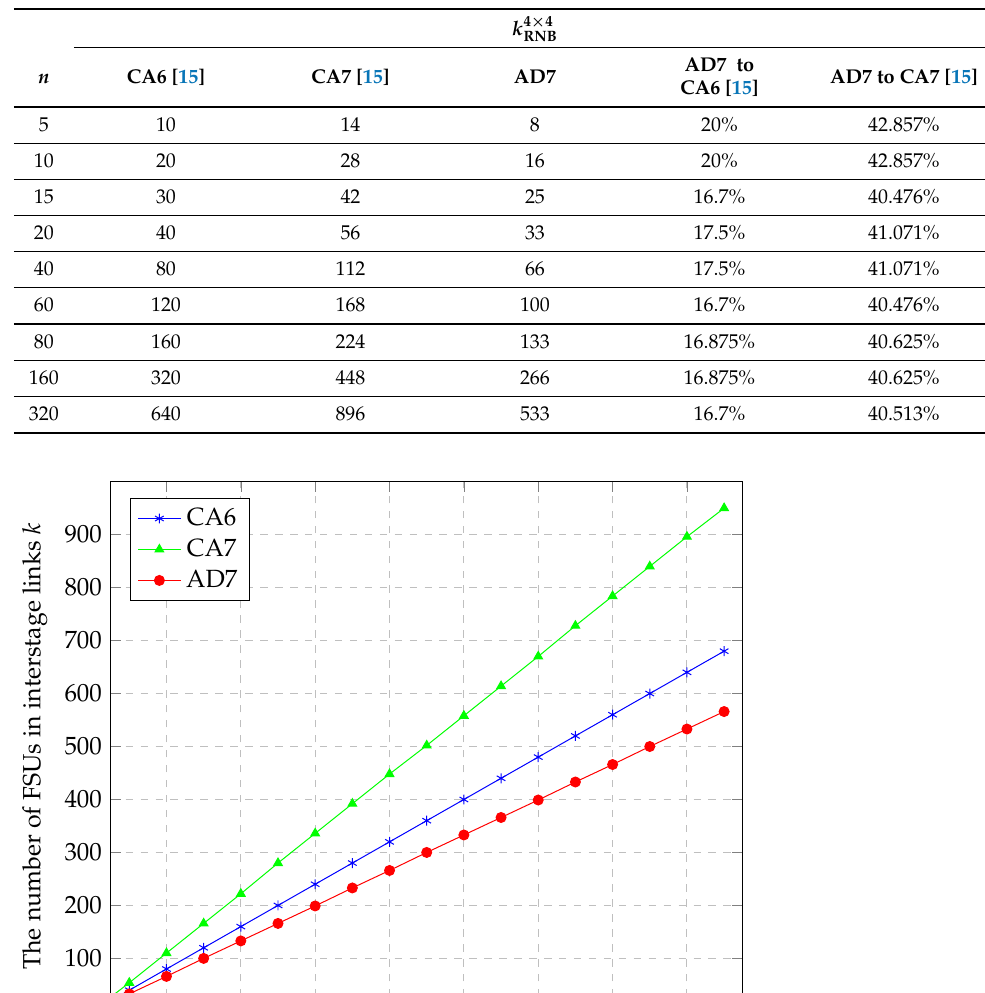
Table 4. Comparison of k 4 × 4 presented in [15] and required by Theorem 1. RNB